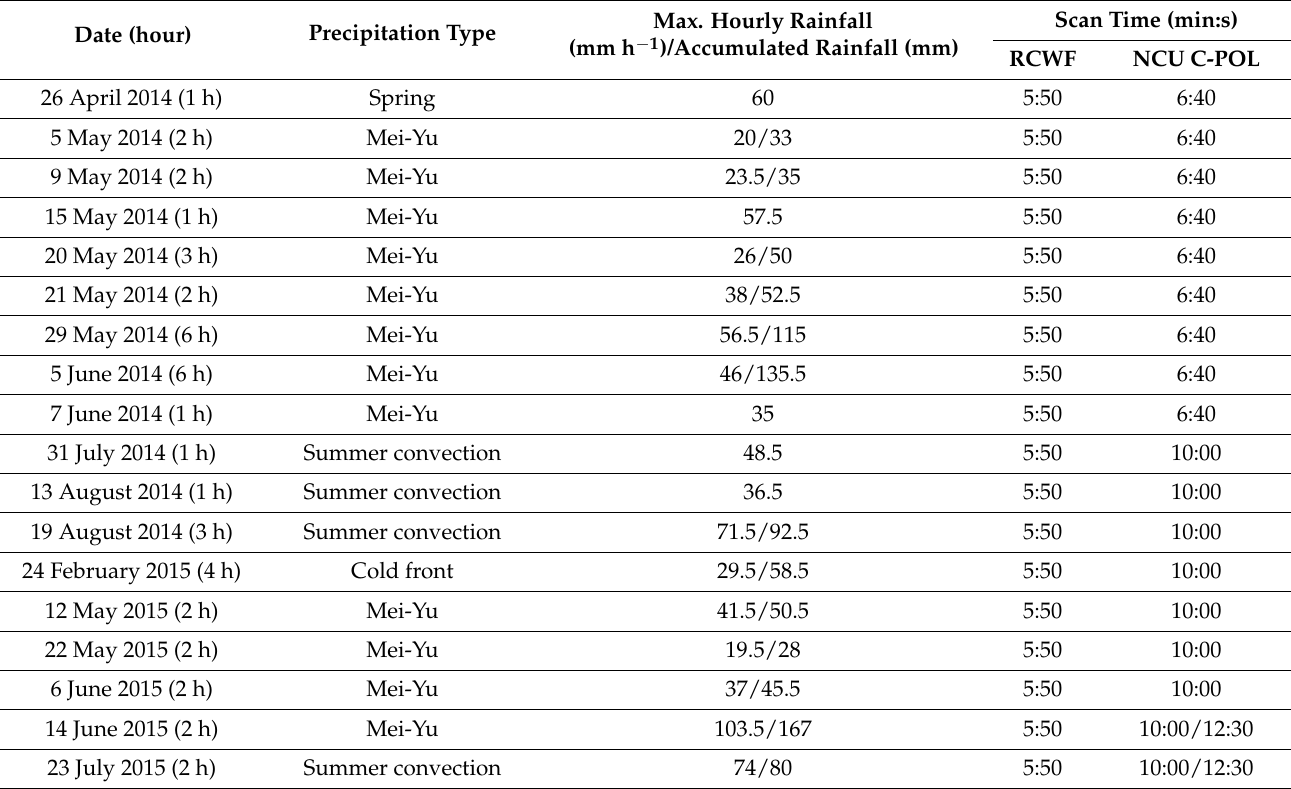
Table 4. The information of 18 heavy rainfall events investigated in this